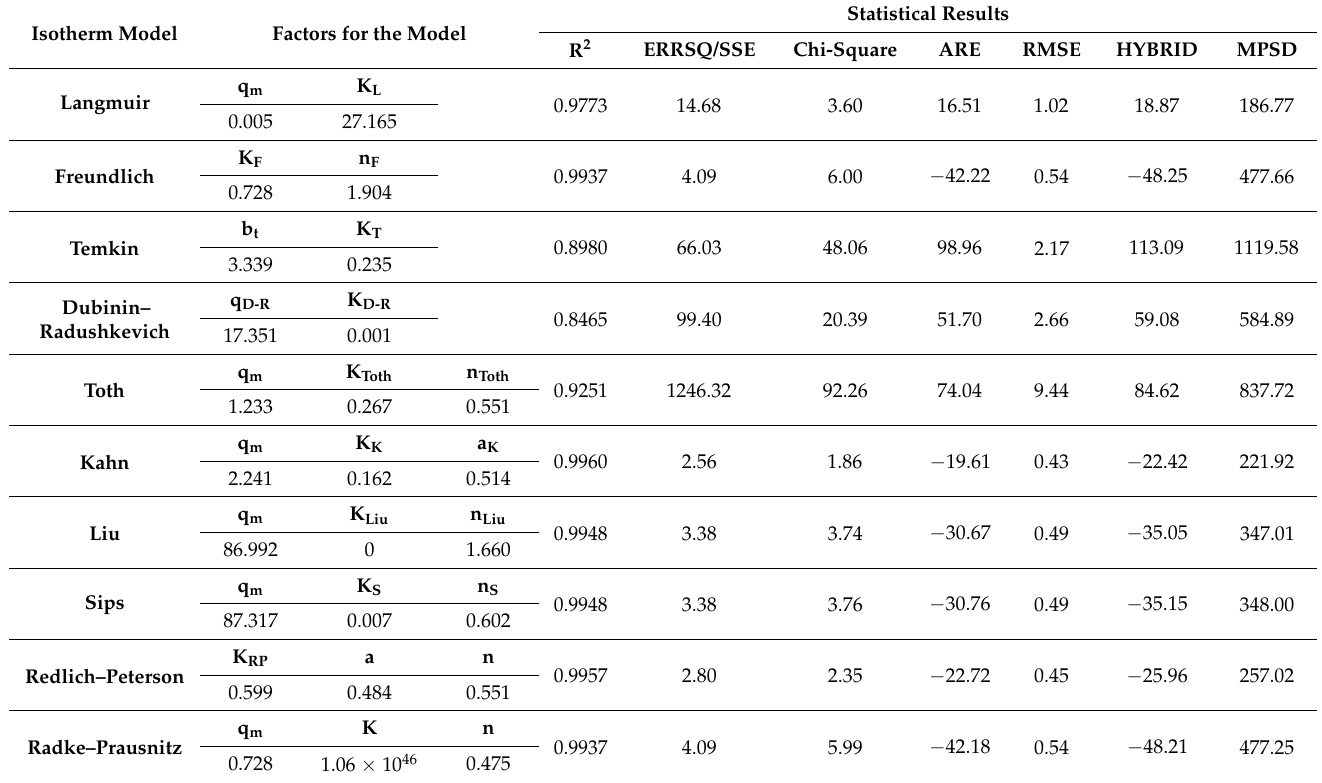
Table 2. Calculated parameters of nonlinear isotherm models for RR dye adsorption onto brewery